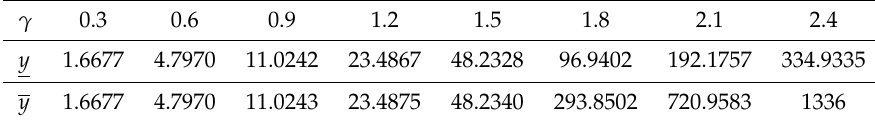
Table 5. Computation of solution at multiple grid points for γ =